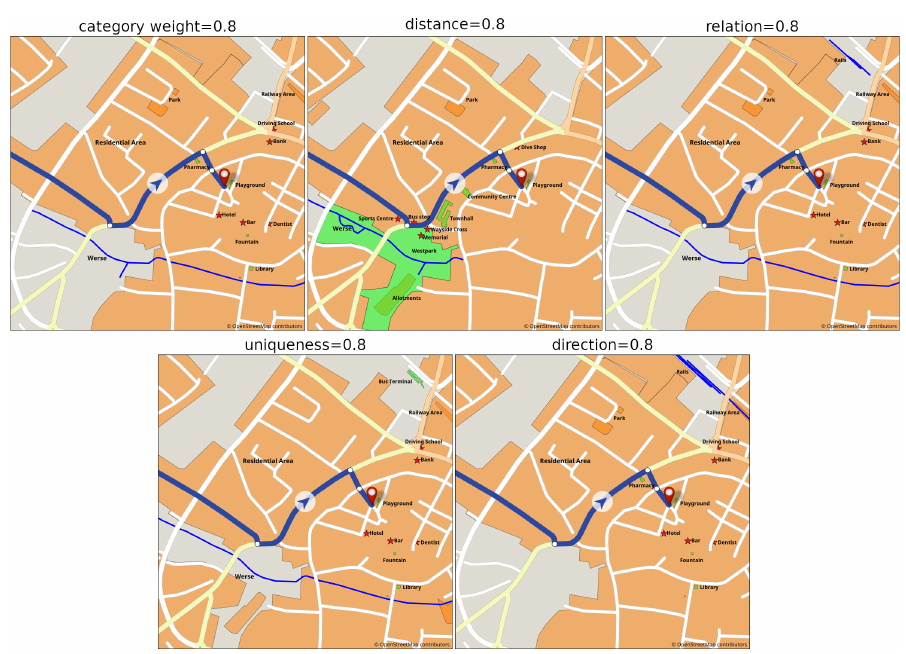
Figure 4: Results the systematic investigation of different metric